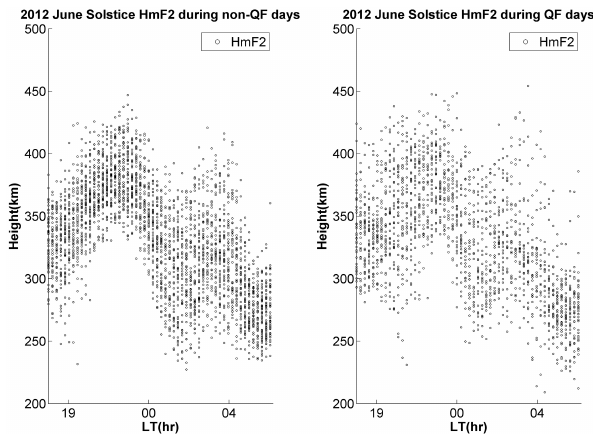
Figure 5. Local time variations of F layer peak height over Sanya during June solstitial non-QF days (left) and QF days